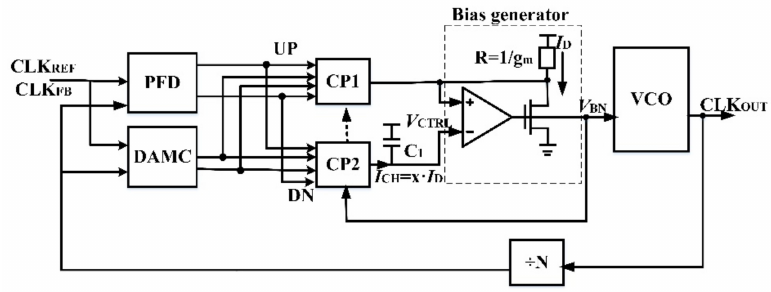
Figure 1. The proposed block diagram of the self-biased PLL with